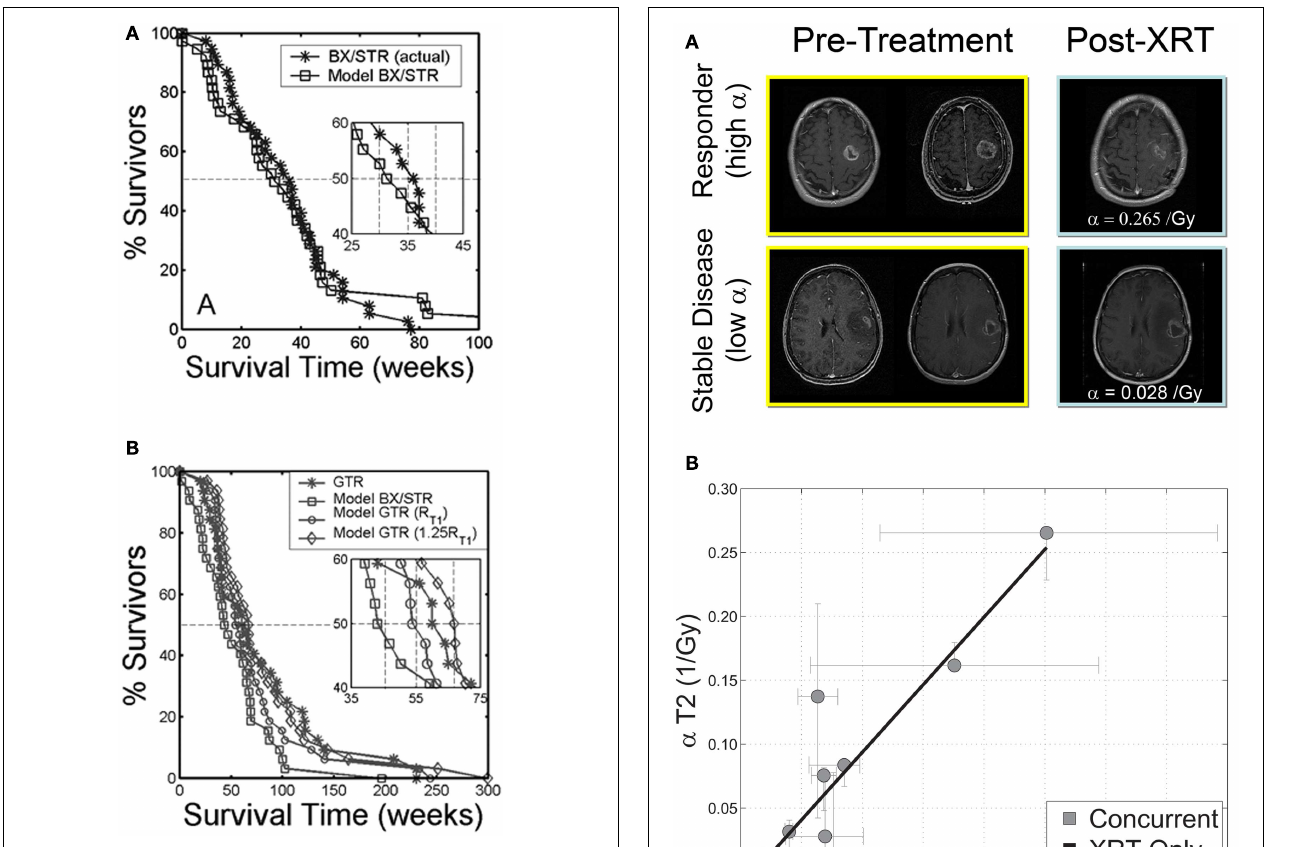
FIGURE 8 | “ (A) Survival curves for actual glioblastoma patients (asterisks) and virtual patients (squares) subjected to biopsy or subtotal resection (BX/STR, N = 38). Inset shows a close-up of the survival curves near the median survival times of 32.4 and 36.5weeks. (B) Survival curves on a longer time scale following gross total resection (GTR, N = 32) in actual patients (asterisks) defined by the absence of residual tumor on post-operative enhanced CT.The virtual patients (matched to actual pre-operativeT1-Gd volume and D / ρ ratio derived from theT1-Gd andT2 volumes) were subjected to no resection (BX/STR, squares), to resection of 100% of theT1-Gd volumes or radii, rT1 (circles), and to resection of 125% of theT1-Gd volumes or radii, 1.25 rT1 (diamonds). Inset shows a close-up of the survival curves near the median survival times of 44.9, 55, 62, and 66.9weeks.” Reprinted from Swanson et al. (2008b) with permission from Nature Publishing Group, British Journal of Cancer.